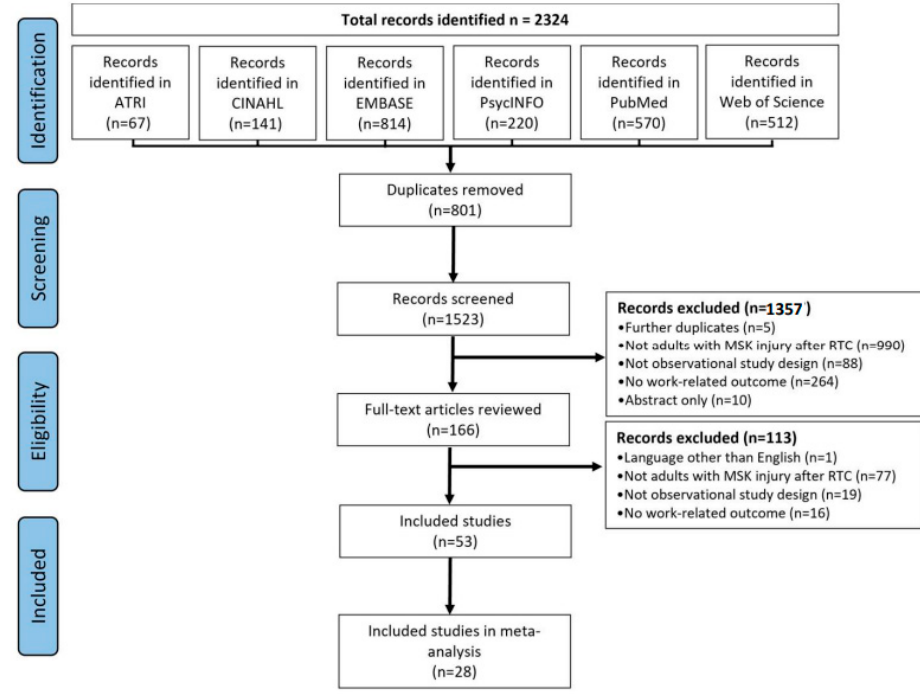
Figure 1. PRISMA